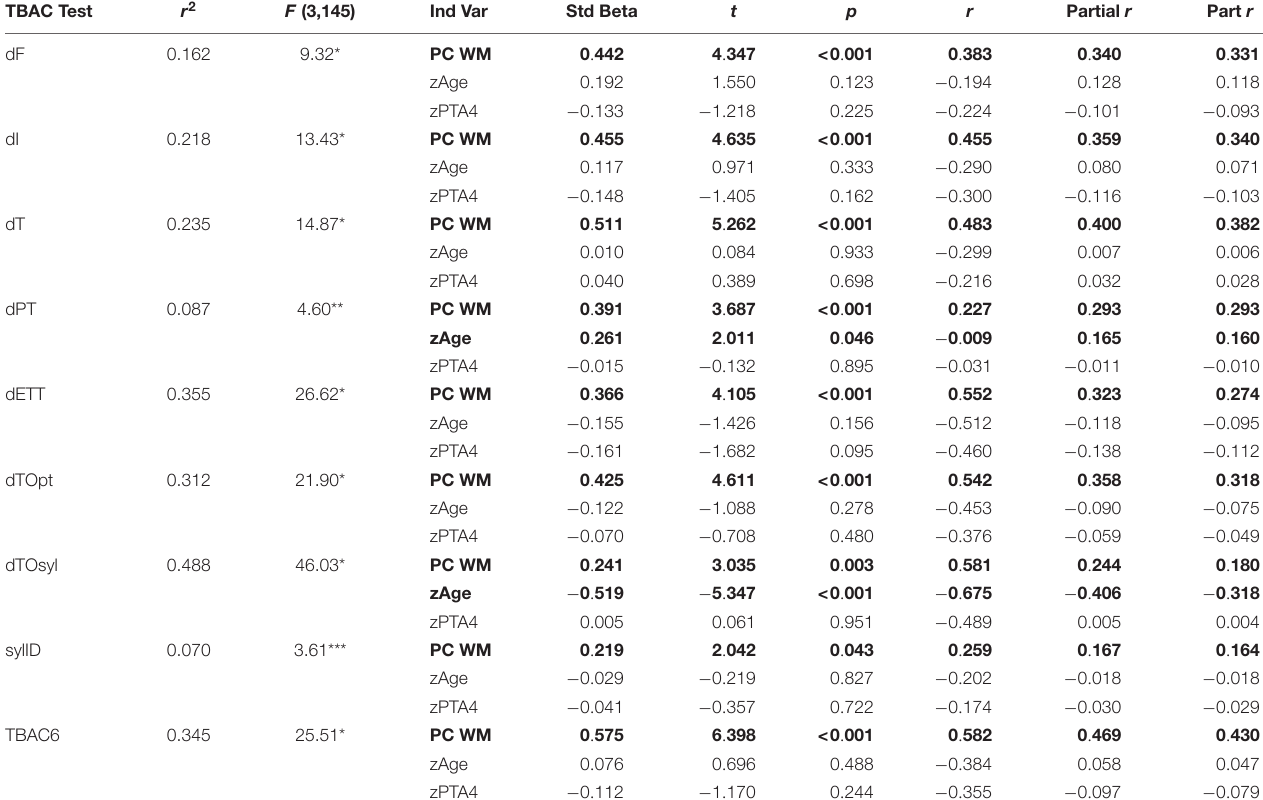
TABLE 2 | Results of the linear-regression analyses for each the test of basic auditory capabilities (TBAC) score (in RAU) for 149 young and older adults. TBAC